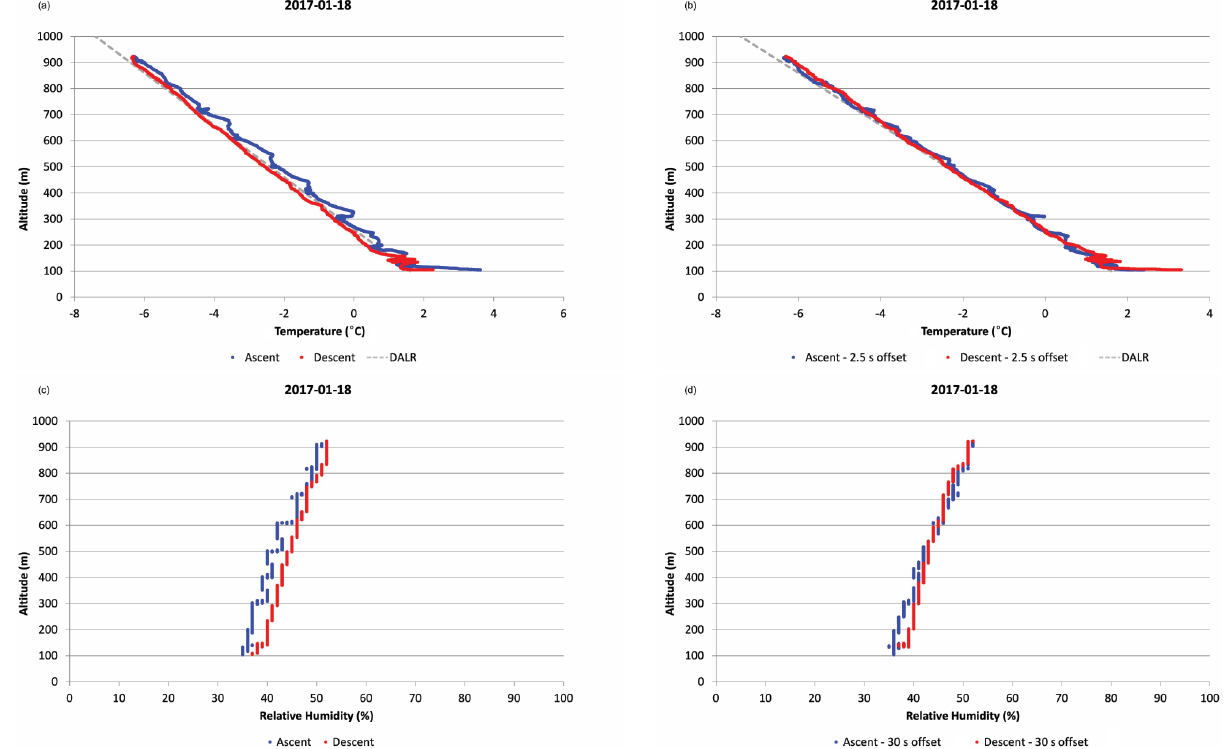
Figure 3. Temperature (a, b) and relative humidity (c, d) profiles observed by the SUMO sUAS in the Wright Valley, Antarctica, at 02:01UTC, 18 January 2017. The original time interpolated data are plotted in panels (a) and (c) , and data with a time lag of 2.5 and 30s are plotted in panels (b) and (d) , respectively. In panels (a) and (b) , the dry adiabatic lapse rate (DALR) is shown with a dashed gray line.